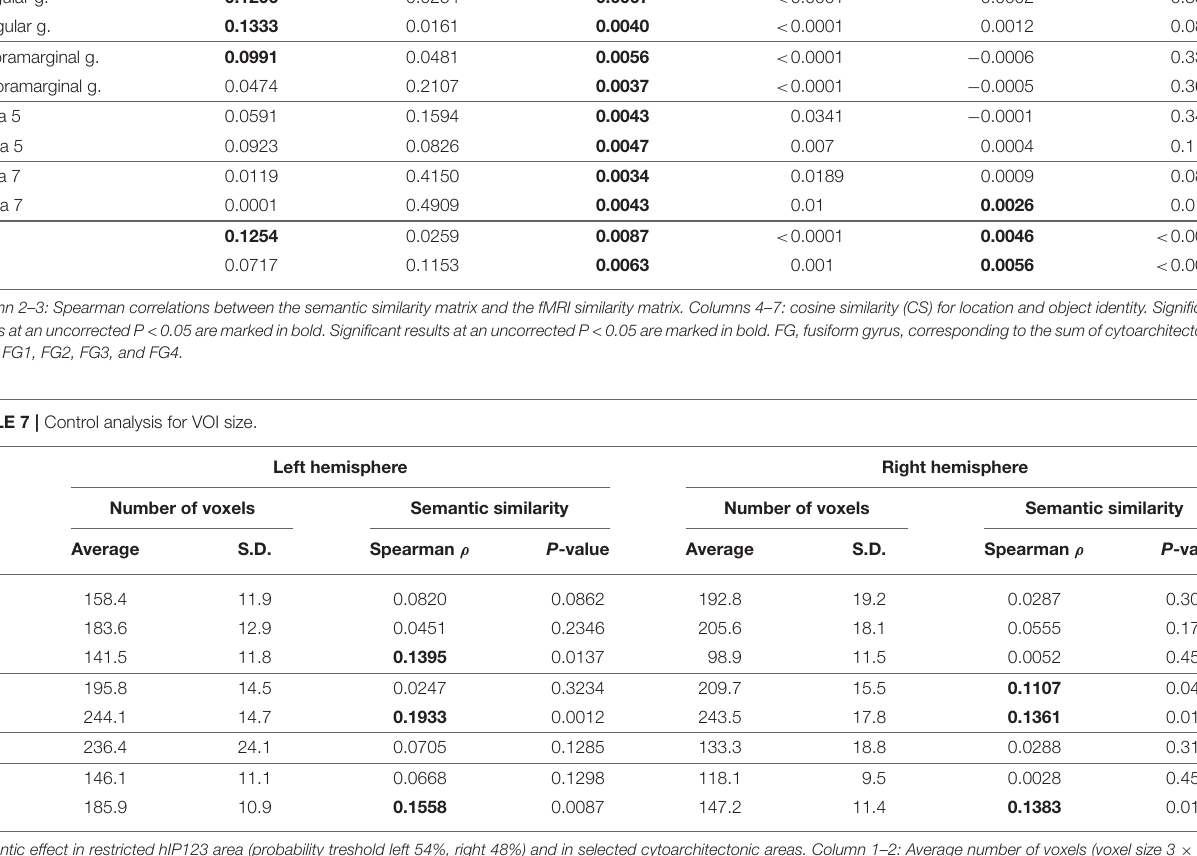
TABLE 6 | Main experiment: Effects for real-life entities outside IPS. Sem. similarity Object identity Location Spearman ρ P -value Cos. similarity P -value Cos. similarity P -value L angular g. R angular g.